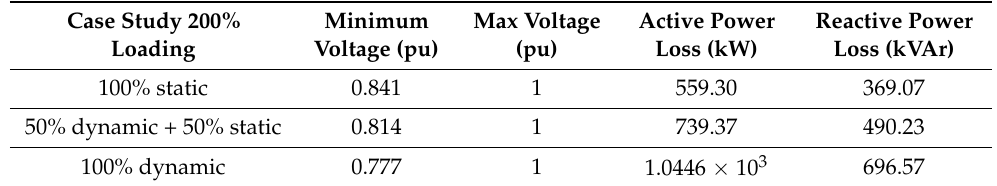
Table 3. Comparison between static and dynamic loads at 200% loading, i.e., a total load of (7161 + j3490) kVA.